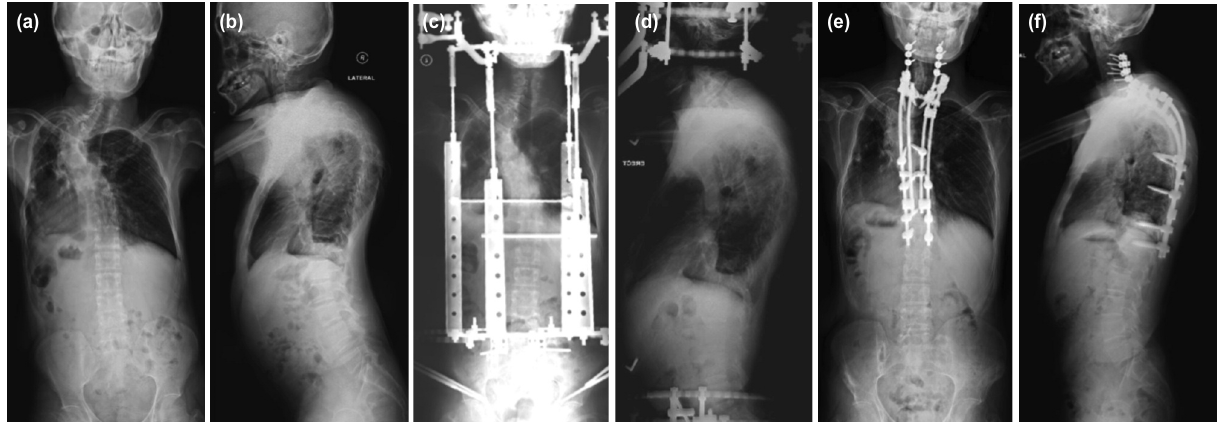
Plain radiographs (posteroanterior and lateral view) of Case 4: (a, b) before operation, (c, d) while on halo-pelvic traction, and Fig. 4: (e, f) after single-stage posterior spinal fusion.